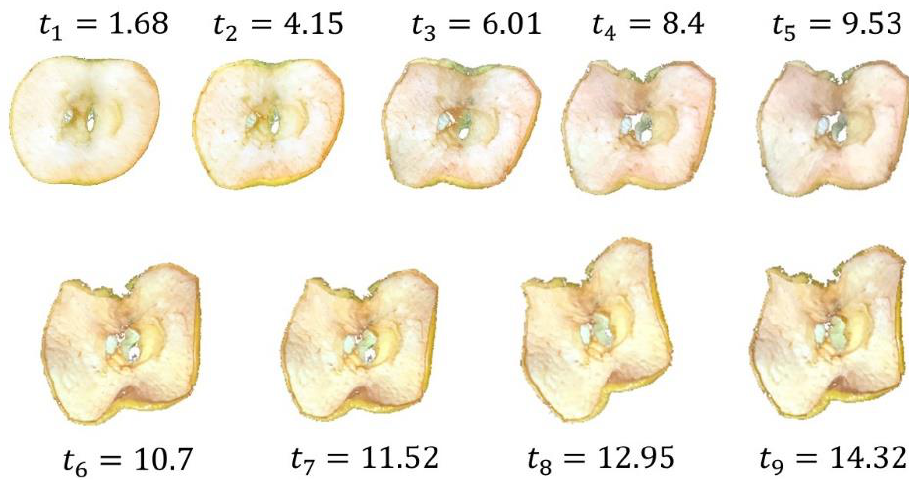
Figure 7. Dehydration of apple slice two over time.